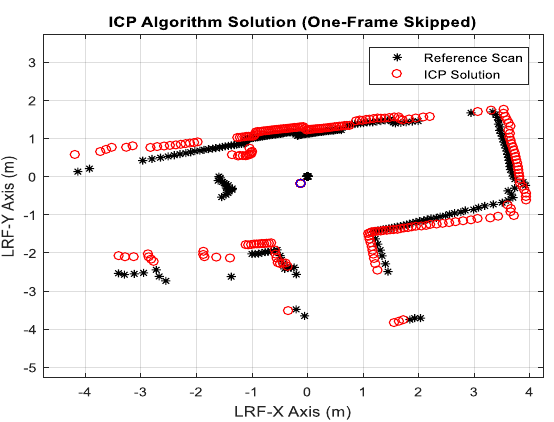
Figure 6. ICP Algorithm performance when one frame is skipped during the harsh maneuver (first experiment, one frame skipped)